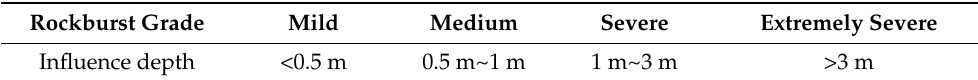
Table 4. Influence depth of